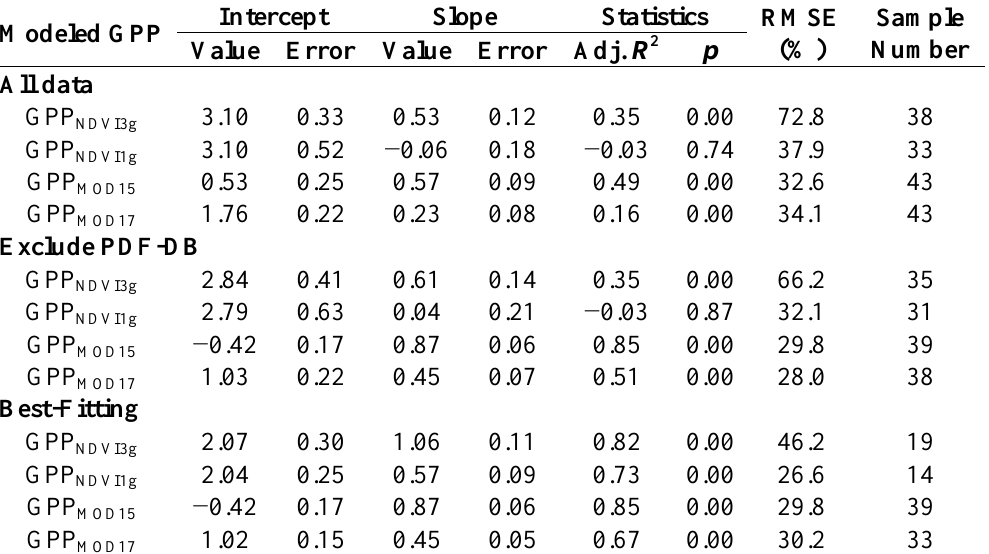
Table 3. Comparison of linear regression results of modeled (GPPMOD) and observed GPP (GPPOBS) with the formula: GPP modelled by GLOPEM-CEVSA with FPAR from GIMMS NDVI3g, GIMMS NDVI and